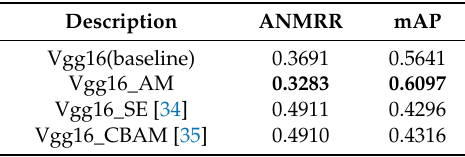
Table 3. Comparisons of different attention modules. The best result is reported in